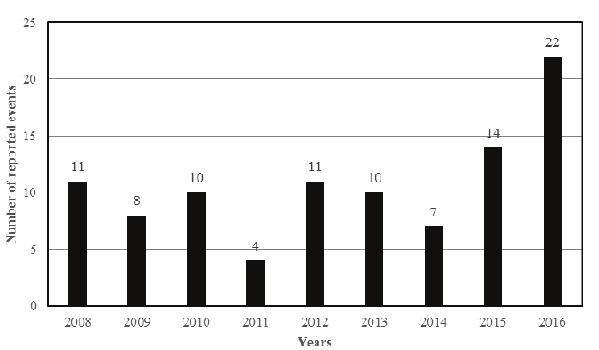
Fig. 8. Number of events caused by piston engines installed on Polish registered aircraft in the ATA 72 chapter between 2008-2016